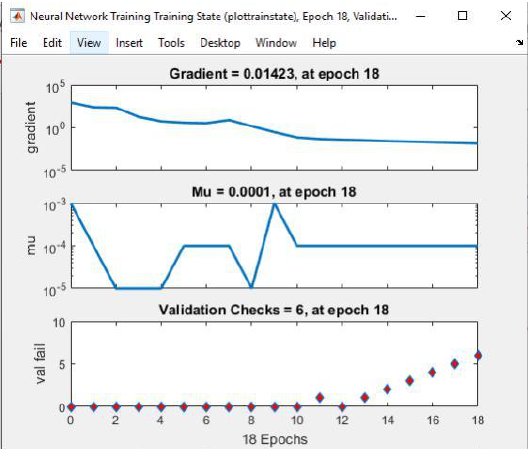
Figure 7 . After 18 epochs the level og gradient, Mu and Validation Fail approajhes to